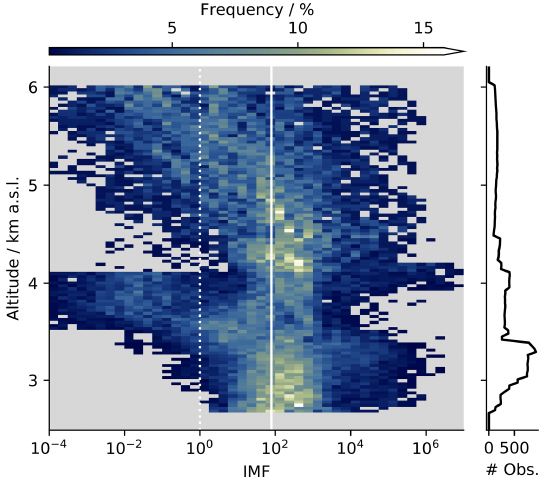
Figure 13. As for Fig. 12, but with the altitude converted to tem- perature using data from the COSMO-1